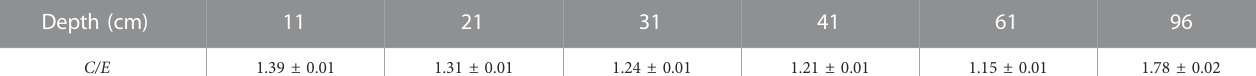
TABLE2 C / E withonestandarddeviationforthe accumulated neutronyields inthe neutron energy region from0.003 MeV – 10 MeVinthe ironshieldfor a350-keVD-T neutron source. The experimental data only includes uncertainty due to counting statistics.